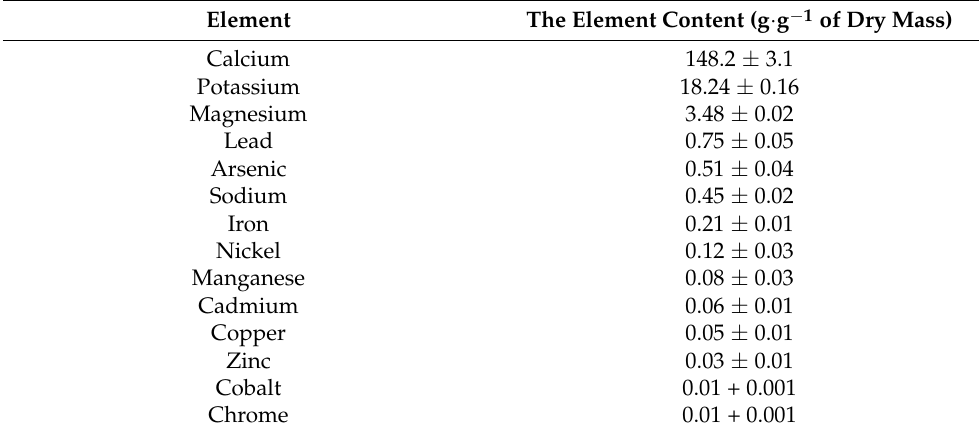
Table 7. Elemental composition observed in the freshwater C. glomerata filaments in the summer of 2021.